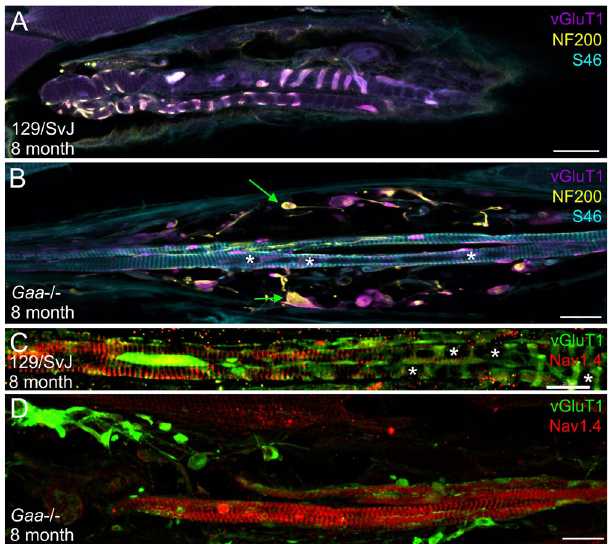
Figure 6. The varicosities formed by the sensory nerve terminal contain cytoskeletal elements and proteins of the polar region redistribute into the central region of intrafusal fiber’s in 8-month-old Gaa −/− mice. Muscle spindles from 8-month-old wildtype ( A,C ) and Gaa −/− ( B,D ) mice were stained with antibodies against vGluT1 (purple channel in panels A and B and green channel in panels ( C,D )), neurofilament 200 (NF 200; yellow channel in ( A,B )), the myosin heavy chain 6 (S46 antibody; blue channel in ( A,B )) and the voltage-gated sodium channel Na v 1.4 (red channel in ( C,D )). In muscle spindles from wildtype 129/SvJ mice, neurofilament 200 immunoreactivity codistributed with the sensory nerve terminal (labeled by the anti-vGluT1 antibodies). The typical annulospiral morphology of the nerve terminal is detectable. In contrast, in muscle spindles from age-matched Gaa −/− mice (panels ( B,D ) show category 3 muscle spindles), the contact between the sensory nerve terminal and the intrafusal fibers was lost and the sensory nerve terminals had retracted to form numerous varicosities. The varicosities labeled by vGluT1 contained neurofilament 200 immunoreactivity (green arrows in panel ( B )), demonstrating the accumulation of cytoskeletal elements in these structures. Note the absence of labeling with the S46 antibody in the central region of 8-month-old wildtype intrafusal fibers ( A ) and its presence in the central region of intrafusal fibers from age-matched Gaa −/− mice ( B ). Likewise, the voltage-gated sodium channel Na v 1.4 was concentrated underneath the subsarcolemmal plasma membrane in the central region of intrafusal fibers of wildtype animals ( C ) whereas it was present throughout the intrafusal fiber in 8-month-old Gaa −/− mice ( D ). Asterisks in panels ( B,C ) indicate the central region of intrafusal fibers. Scale bars: 20